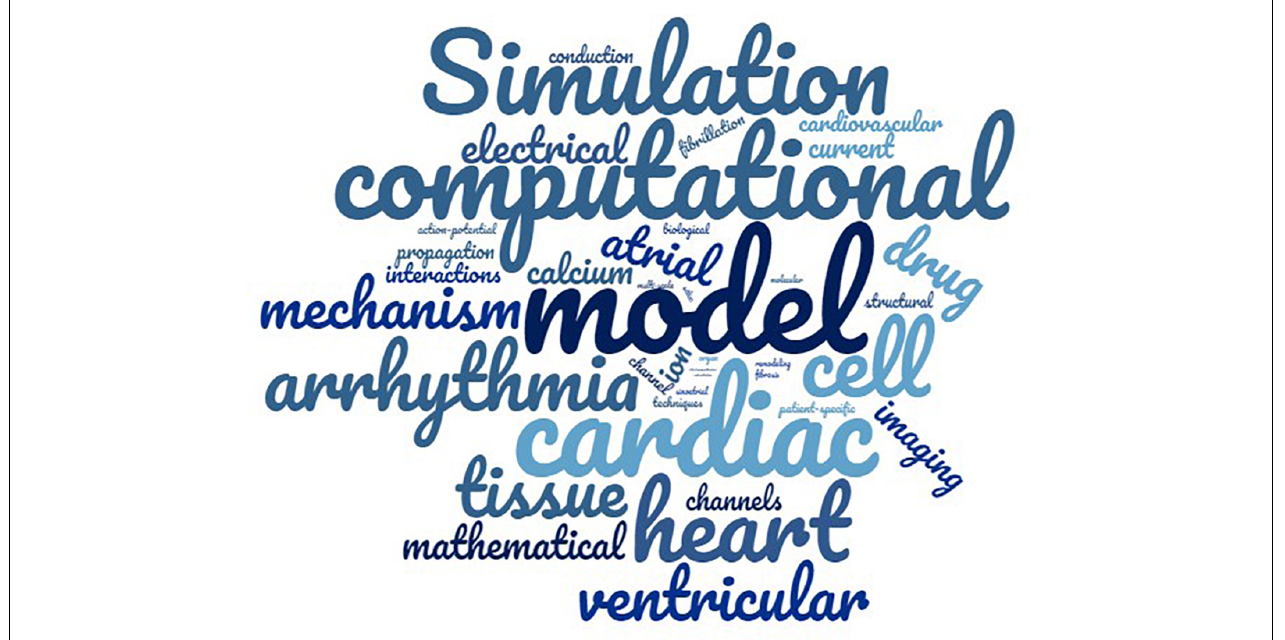
FIGURE 1 | Word cloud of the most frequent words, where the highest the font the higher the frequency. For the purposes of the visualization the terms model, models, modeling, and modeling were grouped under the term “model.” As depicted, the most used words are model, cardiac, computational, simulation, heart, and with frequencies 16.6, 11.16, 7.2, 6.5, and 5.7%, respectively.